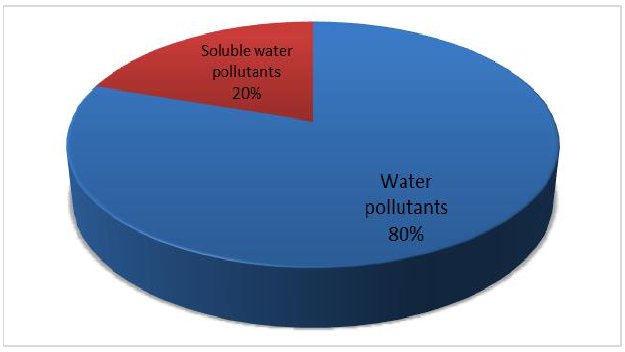
Fig. 8. Percentage of water pollutants at